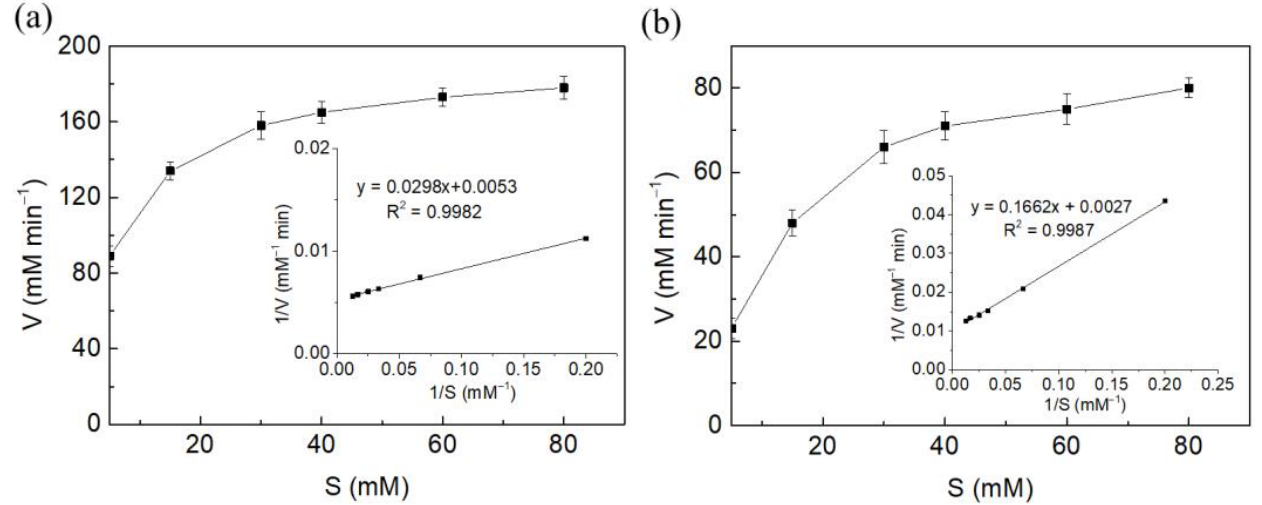
Figure 4. Lineweaver–Burk and Michaelis–Menten plots of free ( a ) and immobilized ( b ) fumarase.